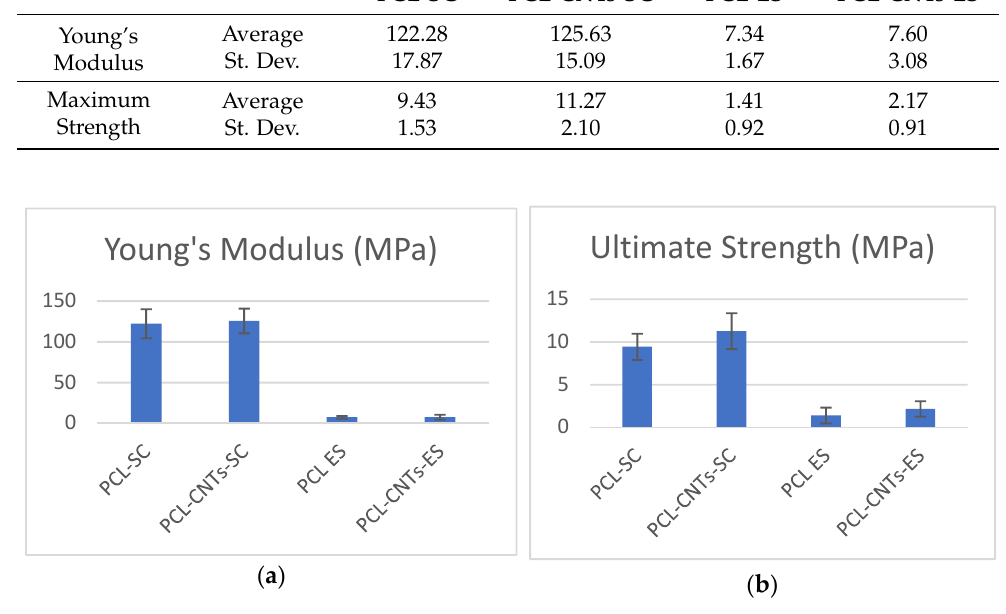
Figure 5. ( a ) Elasticity modulus of the films prepared by solvent casting method vs. films prepared by electrospinning and ( b ) maximum strength.